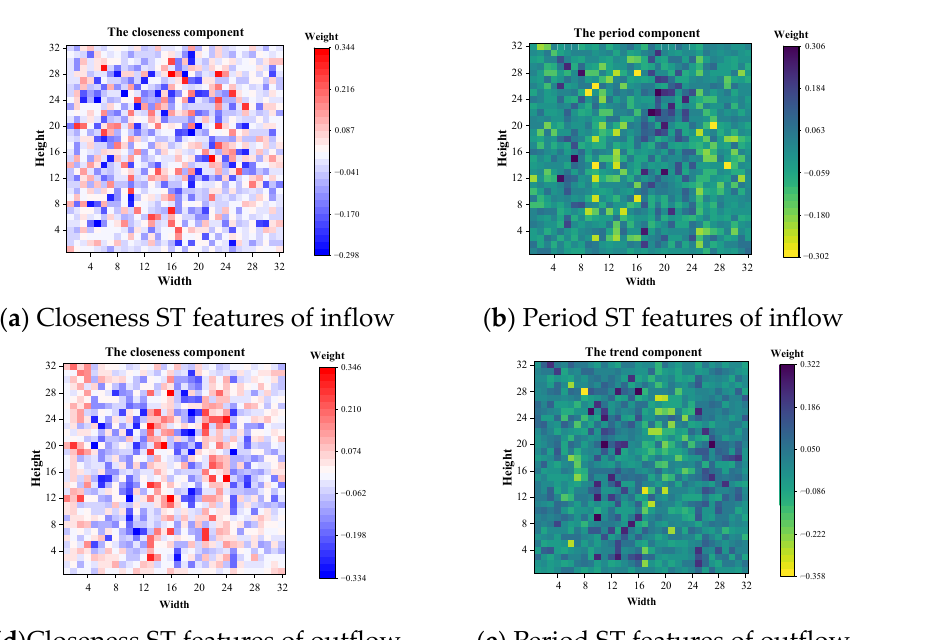
( c ) The trend component Figure 10. Visualization of FSA module for TaxiBJ dataset . To visualize the effectiveness of the MFR module, the weight matrices of the outflows and inflows of the three components closeness, period, and trend in the MFR layer were visualized on its 32 × 32 grid using the TaxiBJ dataset as an example.